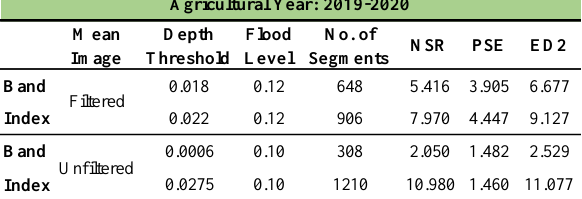
Table 2. Modified ED2 and parameters tested in mean images of spectral bands and vegetation indices for the 2019-2020 agricultural year.